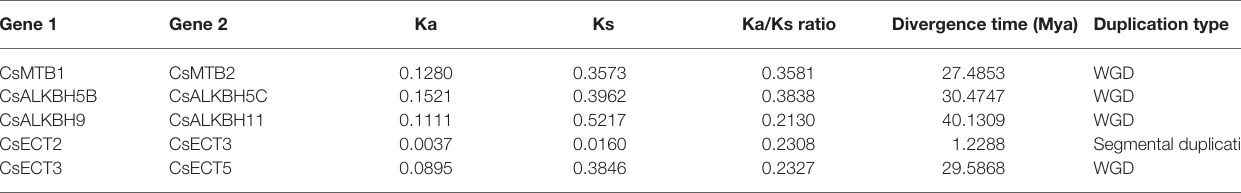
WGD: whole-genome